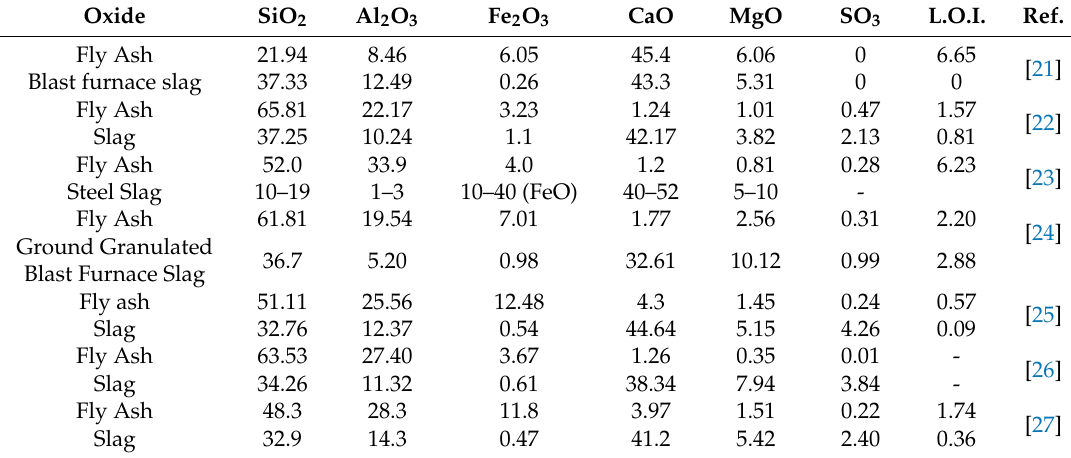
Chemical composition of raw materials used in the production of alkali-activated geopolymer materials, measured by X-ray fluorescence